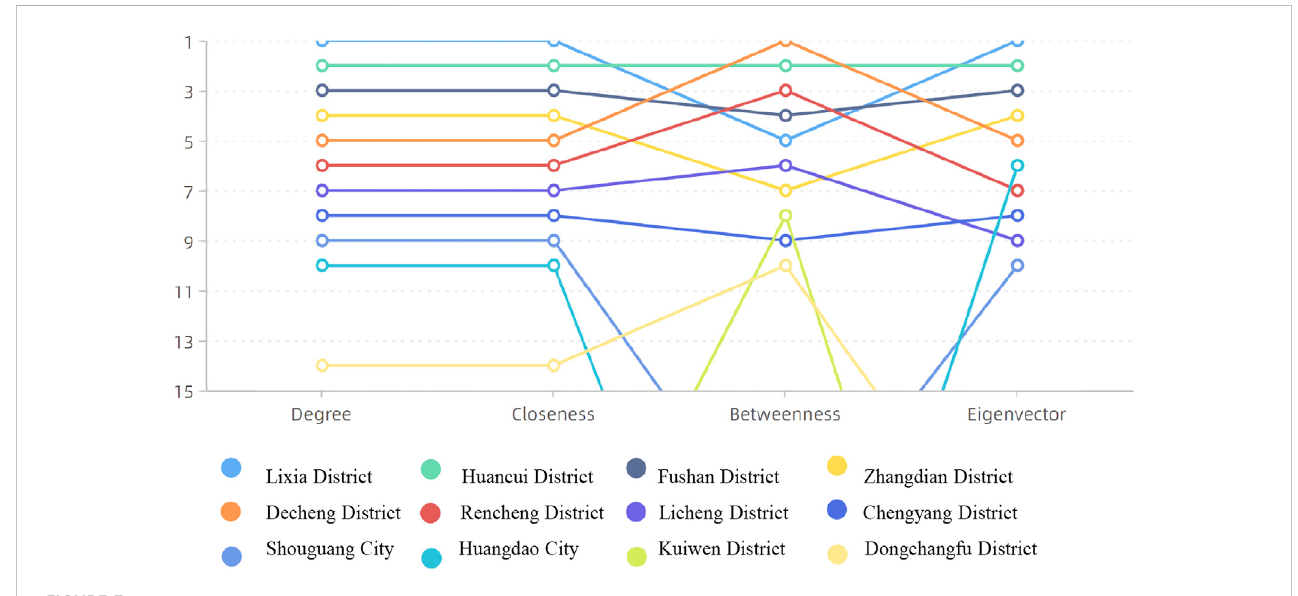
FIGURE 3 Centrality ranking of core and key nodes of city supply networks in Shandong.